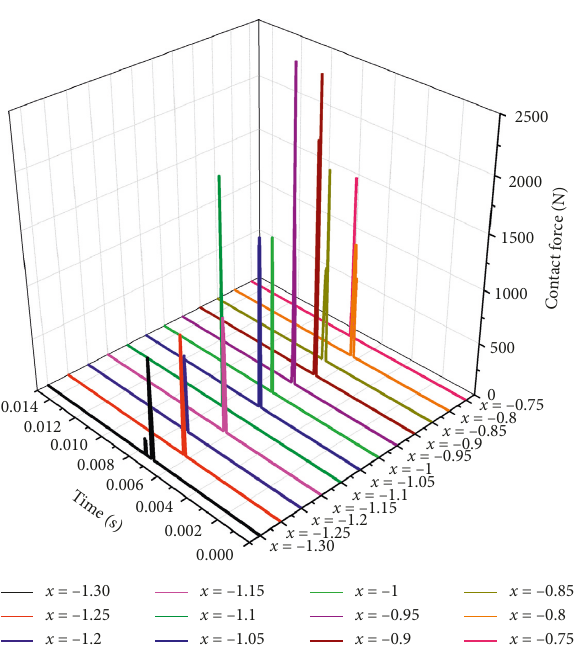
Figure 26: Velocity of the tail